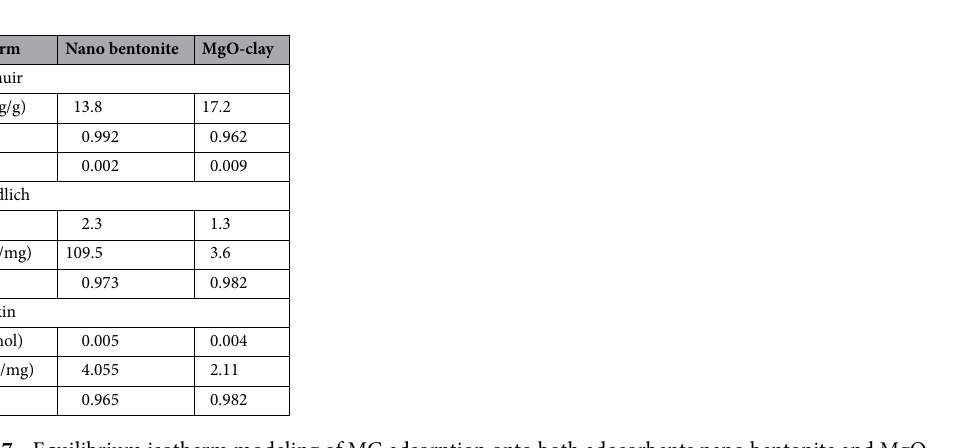
Table 7. Equilibrium isotherm modeling of MG adsorption onto both adosorbents nano bentonite and MgO impregnated clay.